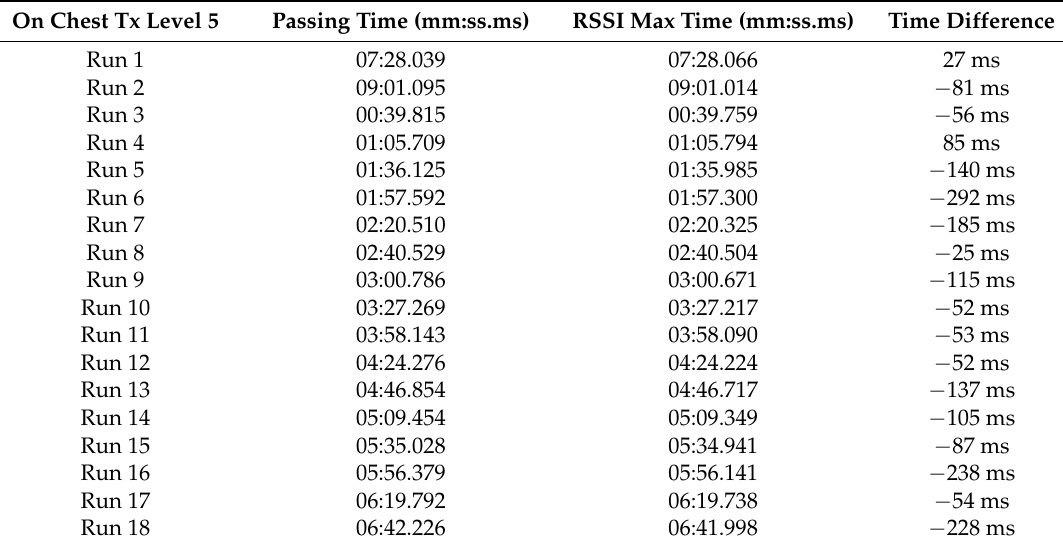
Table 4. The dynamic experiment when the Tx power of the BLE Tag on the chest is set at Level 5. On Chest Tx Level 5